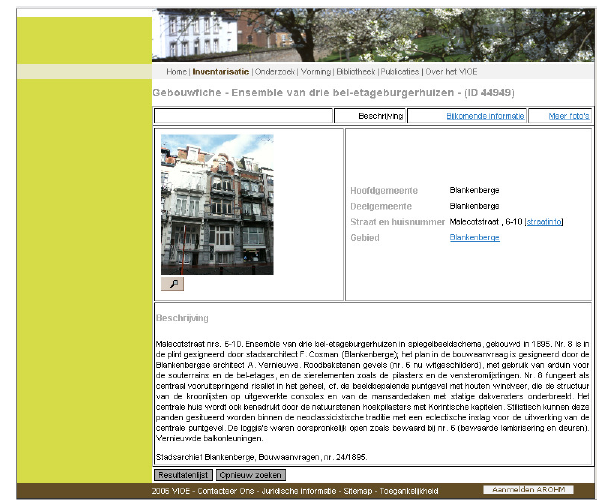
Figure 1: The inventory of architectural heritage circa